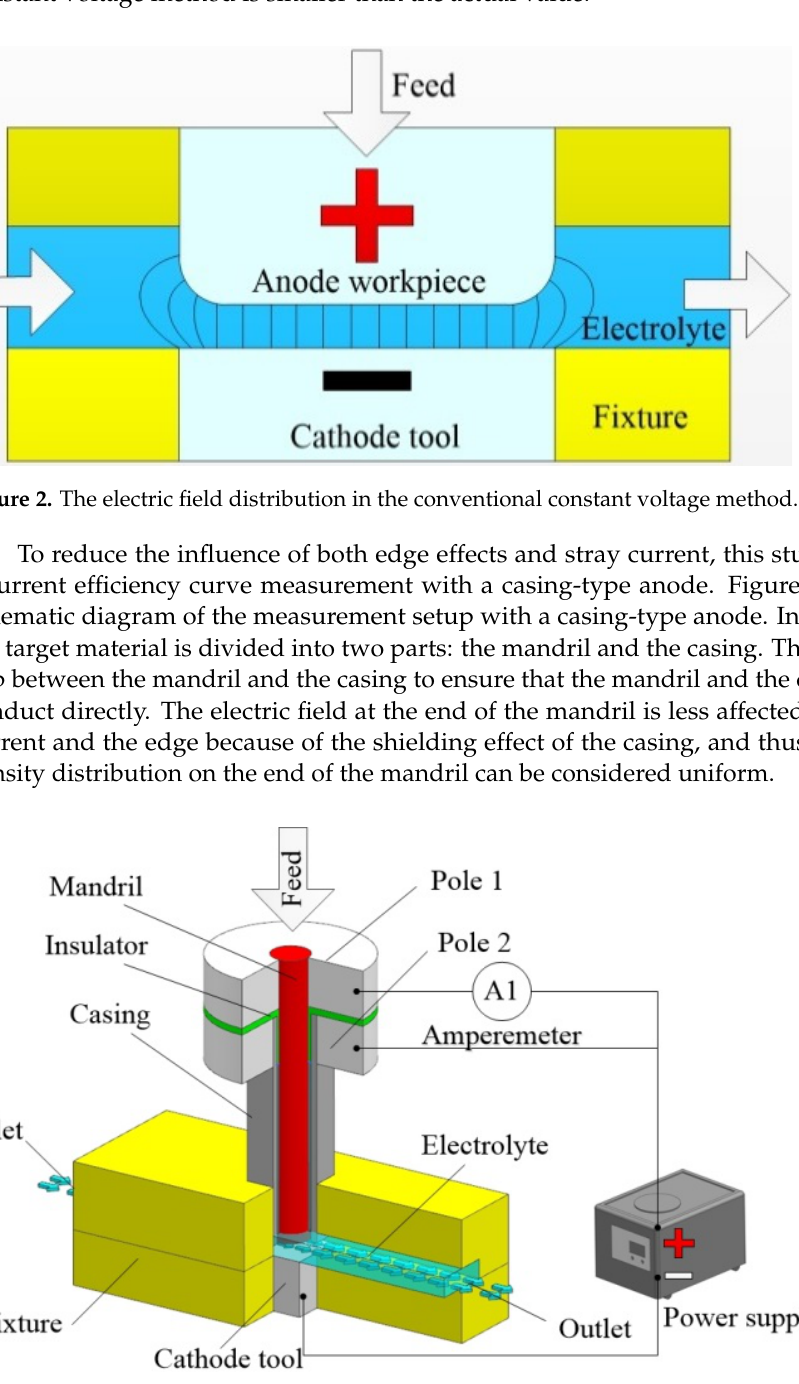
Figure 3. Schematic diagram of the measurement setup with casing-type anode.